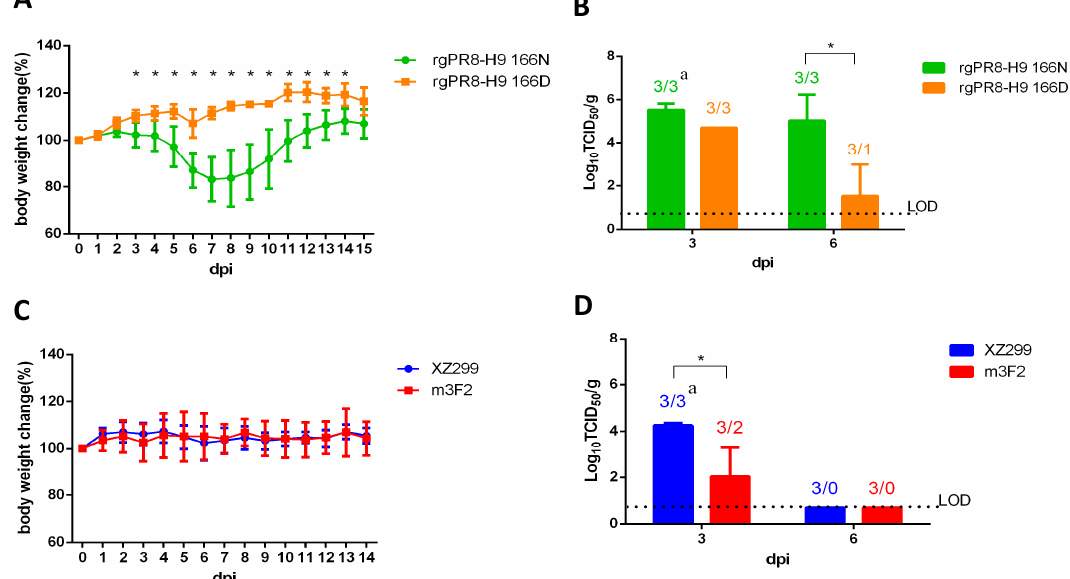
Figure 3. Infection study in mouse. Six-week-old Balb/c mice were inoculated with 10 5 TCID 50 of rgPR8-H9 166N, rgPR8-H9 166D, XZ299 and m3F2 respectively. ( A , C ) Percentage change of